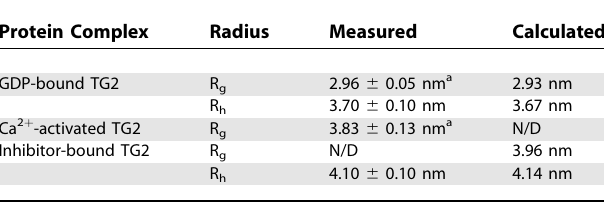
Table 1. Measured Radii of Gyration and Hydration Are Compared to Calculated Values from the Crystal Structures Protein Complex Radius Measured Calculated GDP-bound TG2 R g